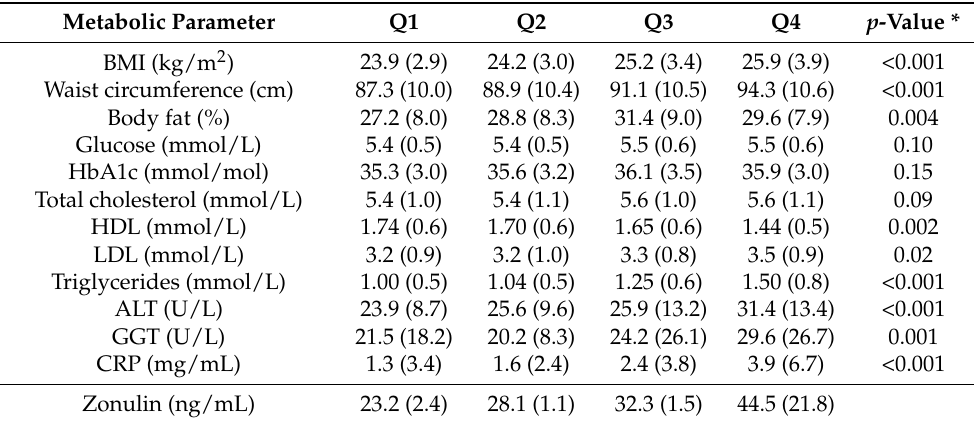
Table 5. The quartile analyses for zonulin including all individuals ( n =